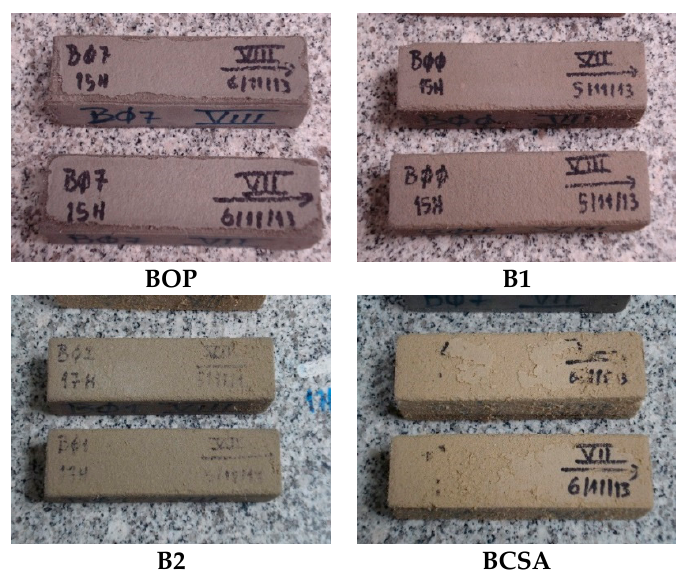
Figure 2. Basecoat mortar specimens after freeze-thaw cycles.